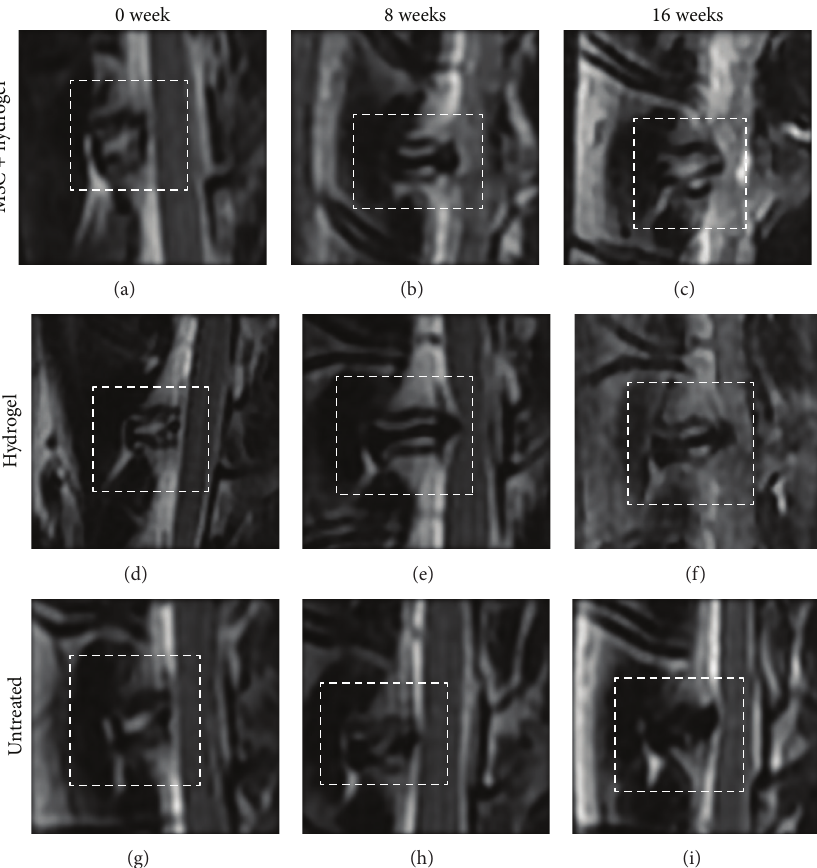
Figure 5: MRI images (T2 weighted sagittal views) before operation, 8 weeks, and 16 weeks after annular puncture was created. MSCs containing hydrogel group I baseline (a), 8 weeks (b) and 16 weeks (c), showing improvement in signal intensity suggesting regeneration of IVD. Hydrogel only group II baseline (d), 8 weeks (e) and 16 weeks (f), showing progression of disc degeneration. Untreated group III baseline (g), 8 weeks (h) and 16 weeks (i), showing progression of